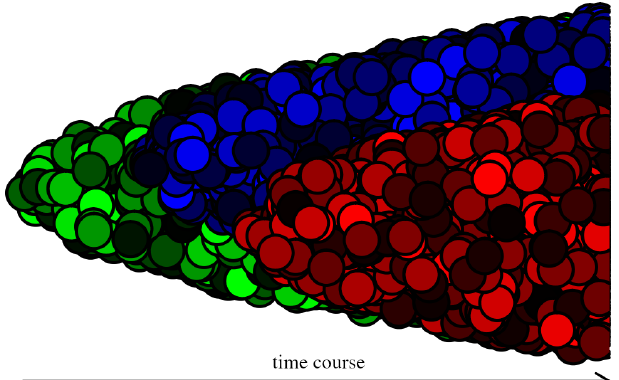
Figure 2. Three genetically different (cancer) clones are depicted—green, blue, and red. In difference with Figure 1, each clone consists of cancer cells in different states, plotted with different